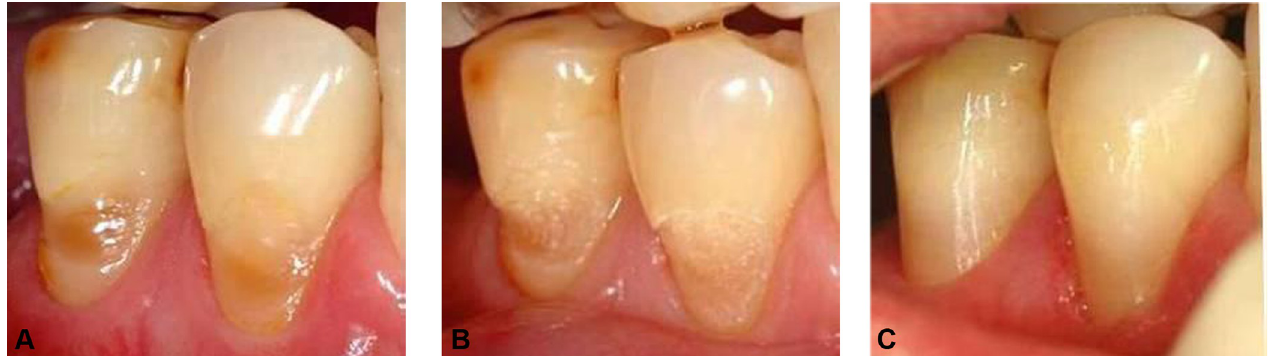
Fig 1. Non-carious cervical lesions of teeth 44 and 45 after laser preparation and restoration with Venus 1 (Heraeus Kulzer, Germany). Class V resin- composite restauration of a non-carious cervical lesions in premolars (44, 45). (A) Initial lesion. (B) After Er,Cr:YSGG laser-based cavity preparation. (C) Cured and finished resin-composite restauration.